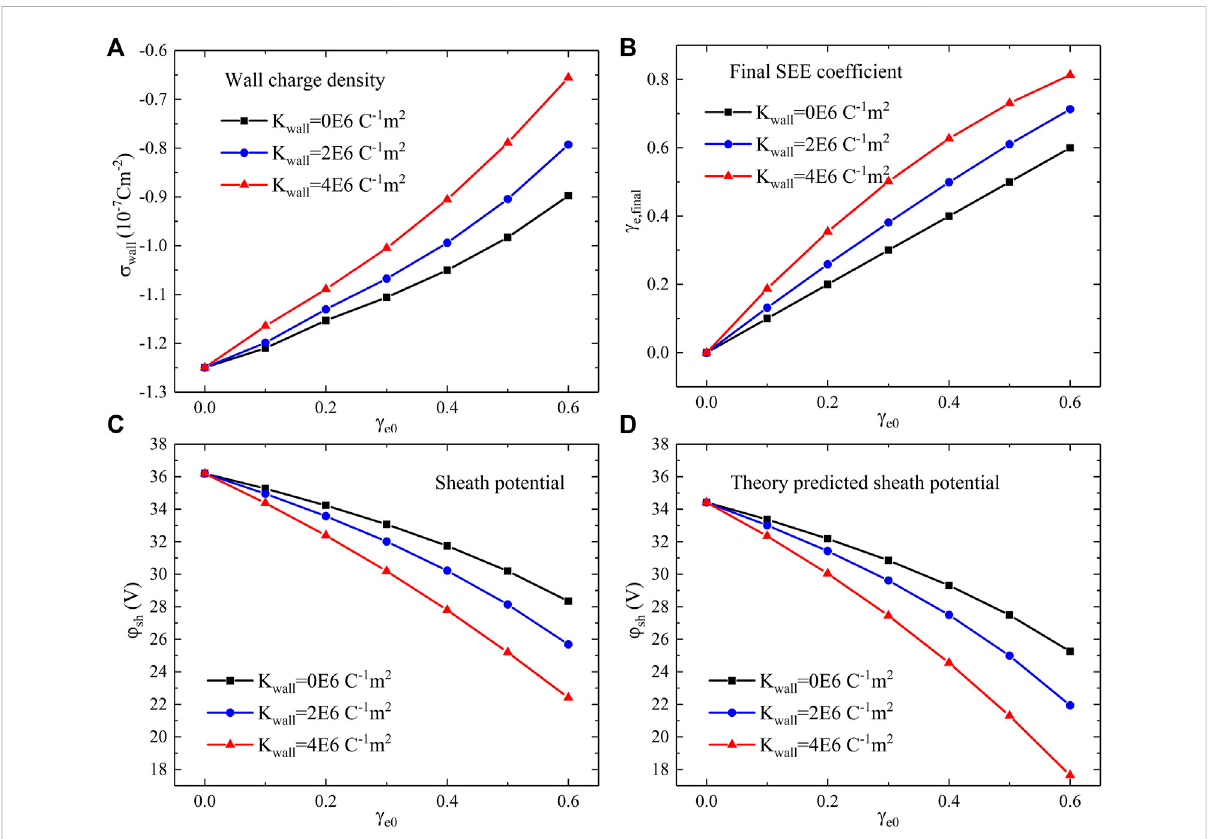
FIGURE 3 Emissive sheath properties with SEE considering the wall-charging effect, for a range of γ e0 with different wall charging factors. (A) Wall charge density. (B) Final SEE coef fi cient after reaching convergence. (C) Sheath potential. (D) Sheath potential predicted by the emissive sheath